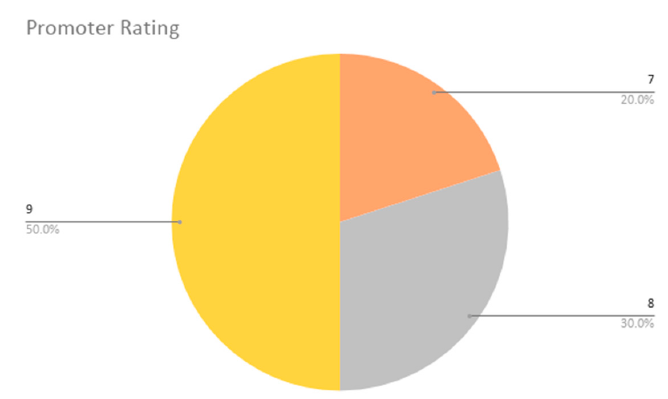
Figure 20. Promoting rating results. The pie chart with promoter rating scores, where 1 = ’Not at all likely Disagree’, 5 = ’Neutral’ and 10 = ’Extremely likely’. From the possible options, only 7, 8 and 9 values were given.